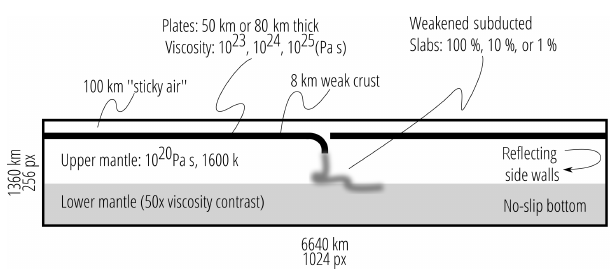
Figure 1. Diagram of the common parameter space, initial, and boundary conditions for